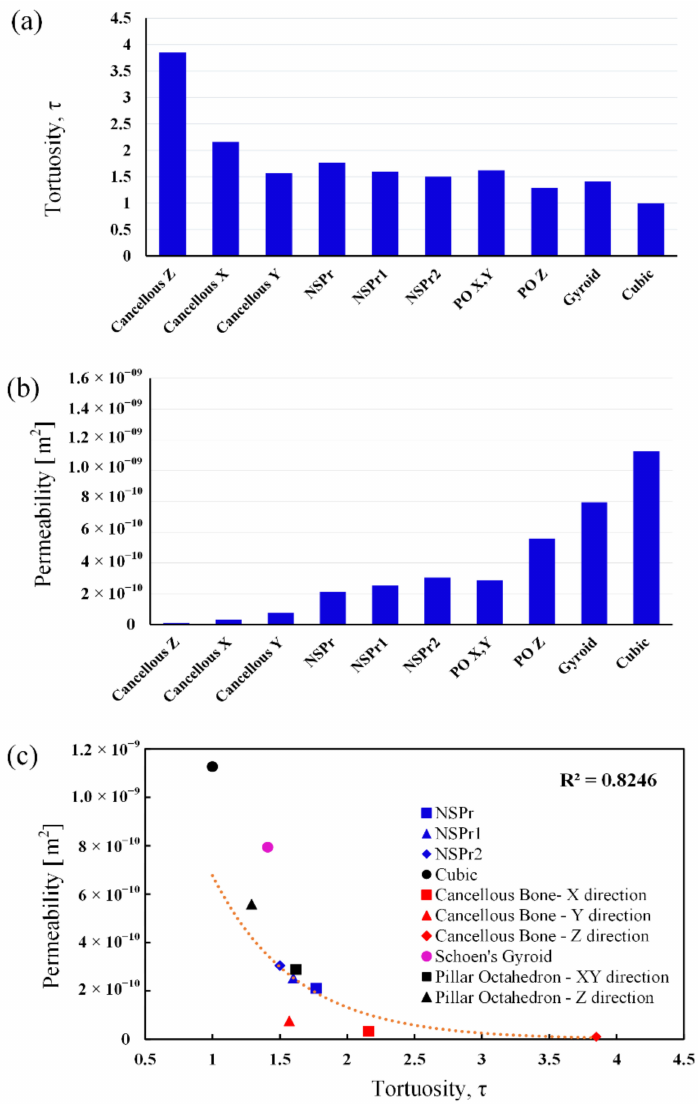
Figure 8. Characterization of various scaffold structures: ( a ) tortuosity of different structures with the same porosity (60%); ( b ) permeability of different structures with the same porosity (60%); ( c ) the relationship between permeability and tortuosity of different structures with the same porosity